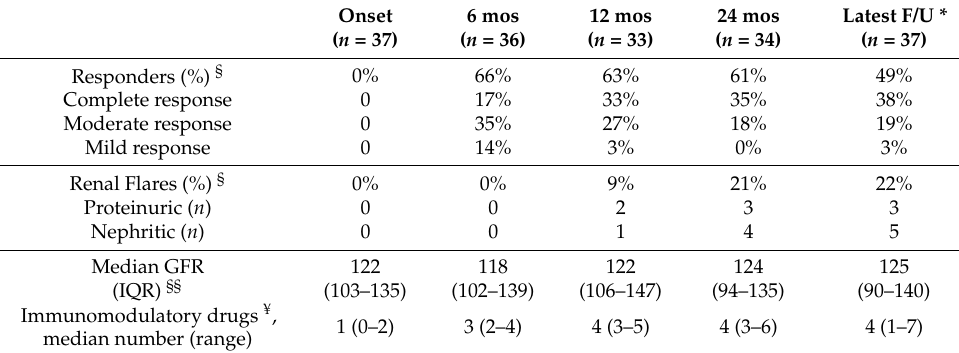
Figure 4. Disease activity scores over time in males with childhood-onset SLE on therapy. The Systemic Lupus Erythematosus Disease Activity Index (SLEDAI) score and Renal-SLEDAI score